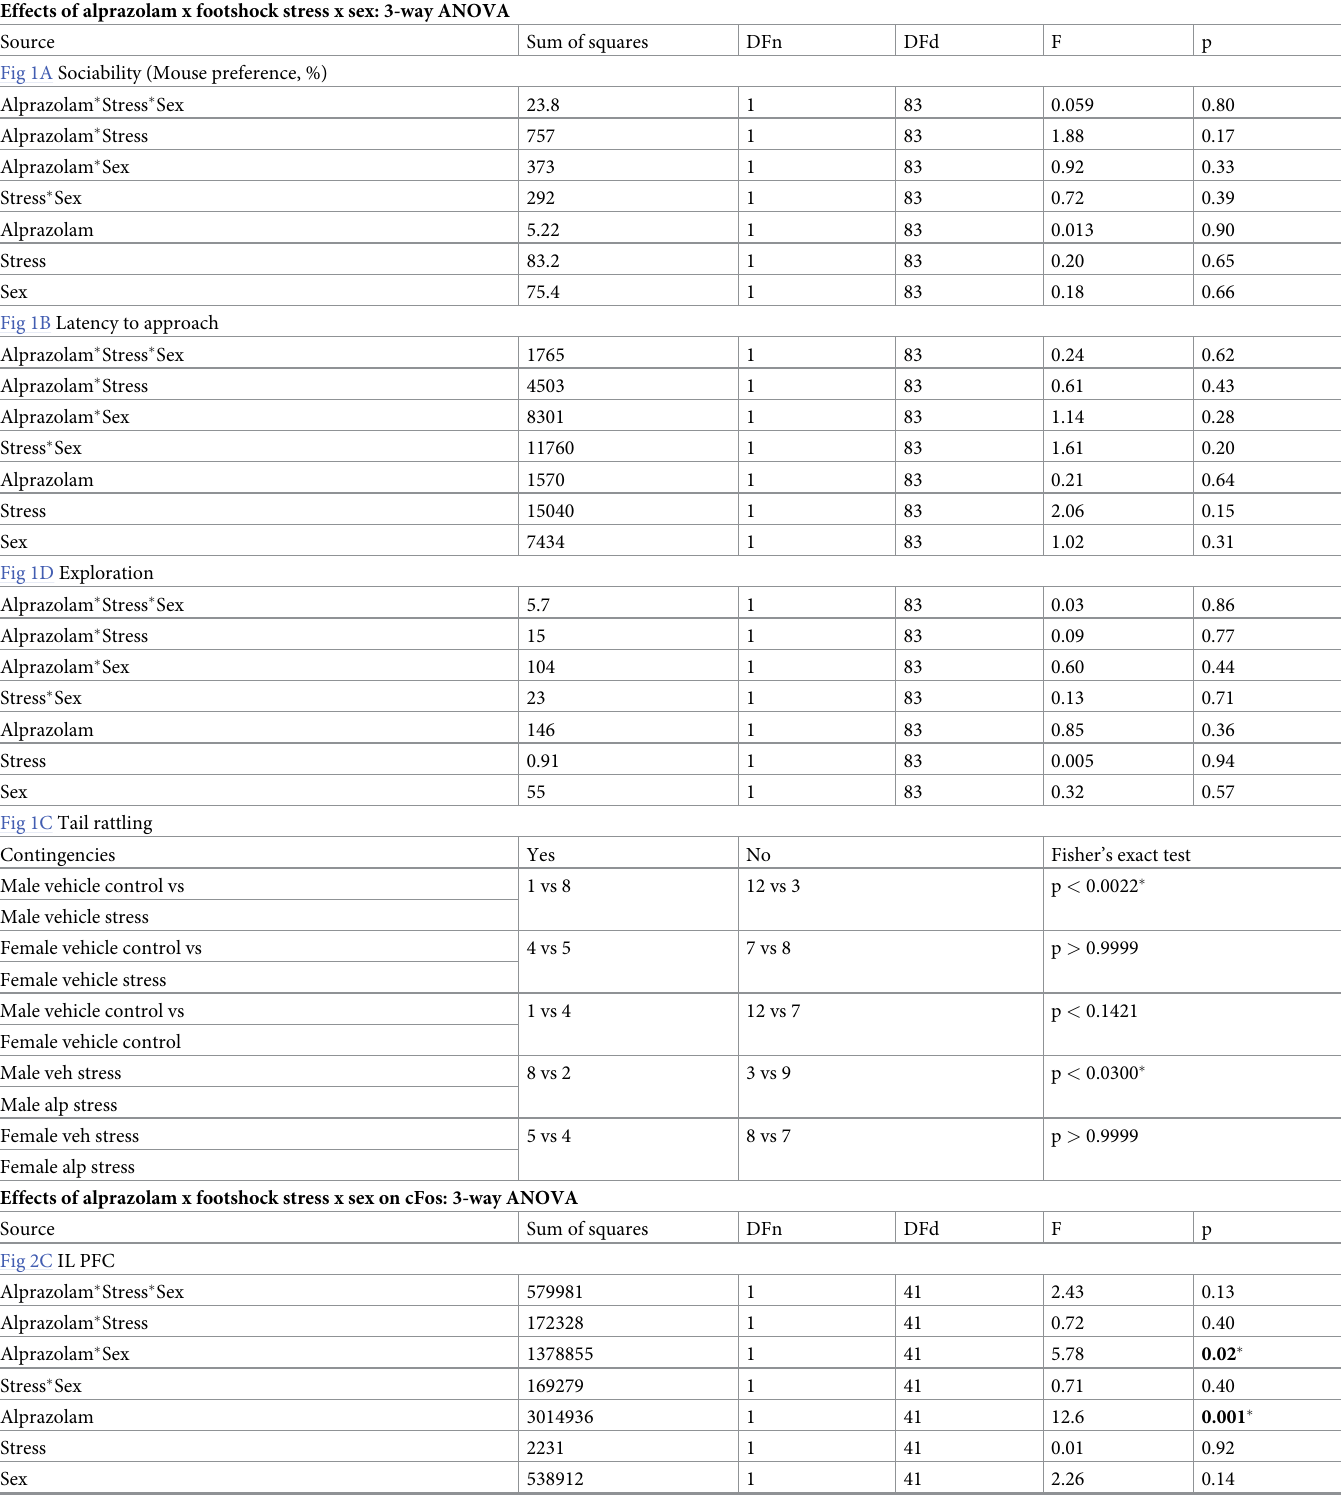
Table 1. Results of statistical